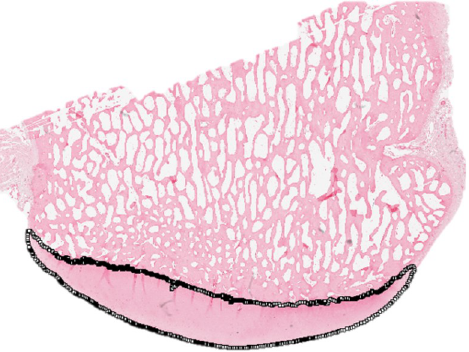
Fig 2. Oriented histologic section from 5 mm thick osteochondral slab and selected region of interest for viable chondrocyte quantification. The region of interest was manually selected in FIJI using the segmented line tool, as demonstrated in this